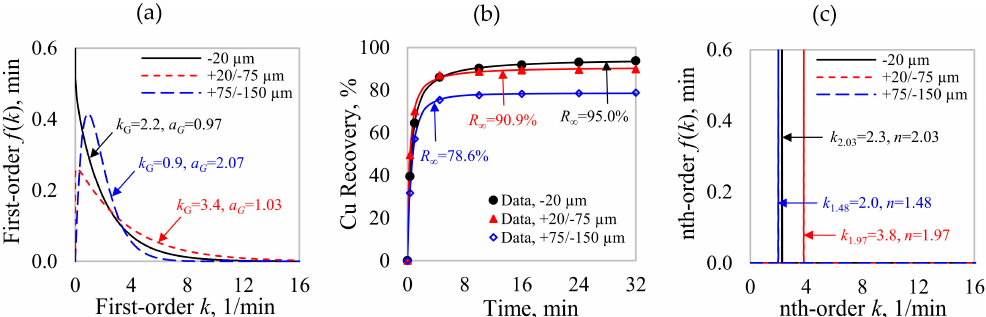
Figure 2. Examples of estimated f ( k )s and model fitting, size-by-size Cu results, ( a ) First-order f ( k )s, Gamma model, ( b ) Time-recovery data, continuous curves obtained by fitting the R ( t ) model of Table 3, ( c ) nth-order f ( k ) s.